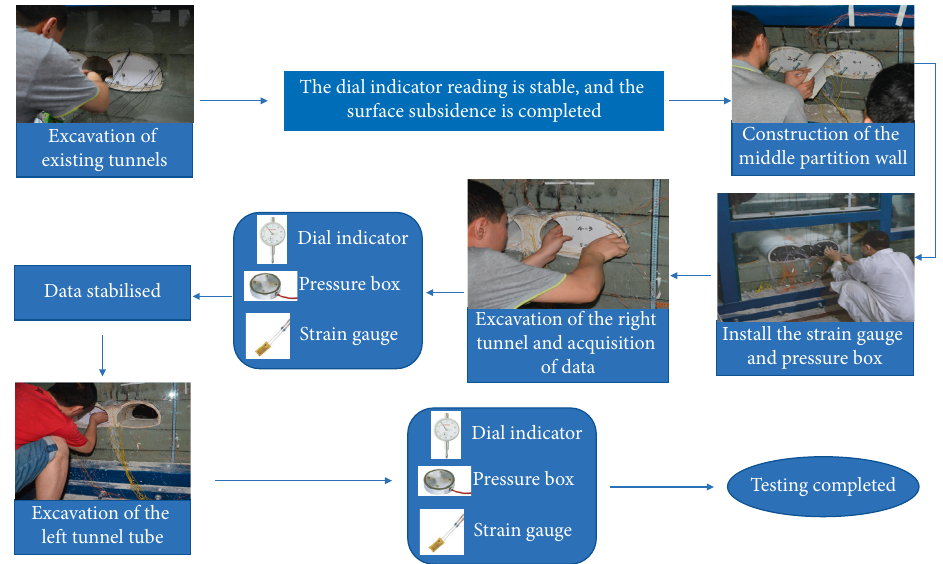
Excavation of existing tunnels